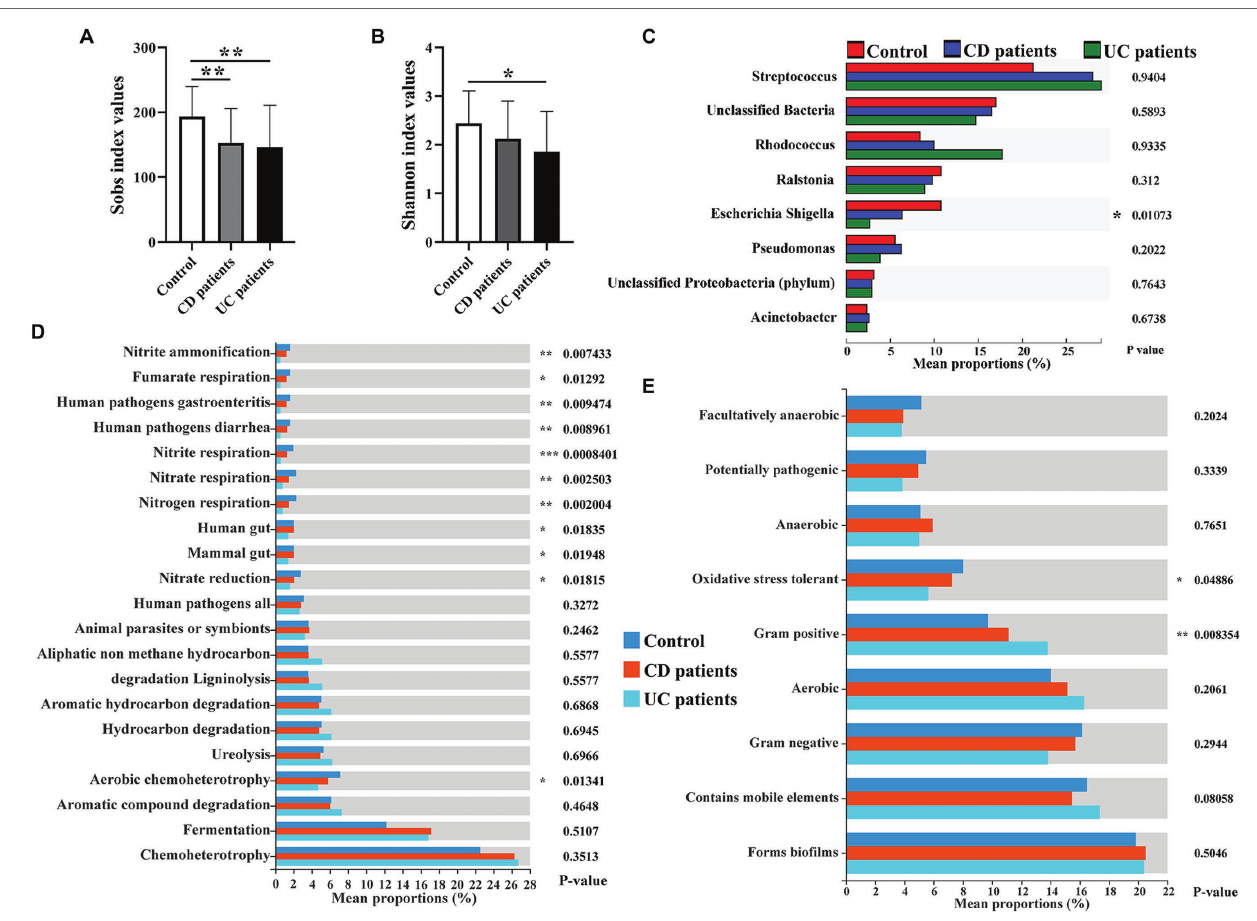
FIGURE 1 | Intestinal mucosa-colonizing bacteria and their potential functional profiles and community phenotypes in control population and inflammatory bowel disease (IBD) patients. Alpha diversity of intestinal mucosa-colonizing microbiota based on Sobs index (A) and Shannon index (B) . (C) Kruskal-Wallis H test compared average composition of intestinal mucosa-colonizing bacteria (top 8) at genus level. Multiple testing correction: false discovery rate (FDR); Post hoc test: Tukey–Kramer (CI = 0.95). All bacteria were named to genus level unless otherwise noted in brackets. (D) Functional Annotation of Prokaryotic Taxa (FAPROTAX) approach predicted potential functional profiles of intestinal mucosa-colonizing bacteria using Kruskal-Wallis H test. Multiple testing correction: FDR; Post hoc test: Tukey–Kramer (CI = 0.95). (E) BugBase predicted community phenotypes of intestinal mucosa-colonizing bacteria using Kruskal-Wallis H test. Multiple testing correction: FDR; Post hoc test: Tukey–Kramer (CI = 0.95). * 0.01 < p ≤ 0.05, **0.001 < p ≤ 0.01, and *** p ≤ 0.001. Control population: n = 23; CD patient: n = 26; and UC patient: n =